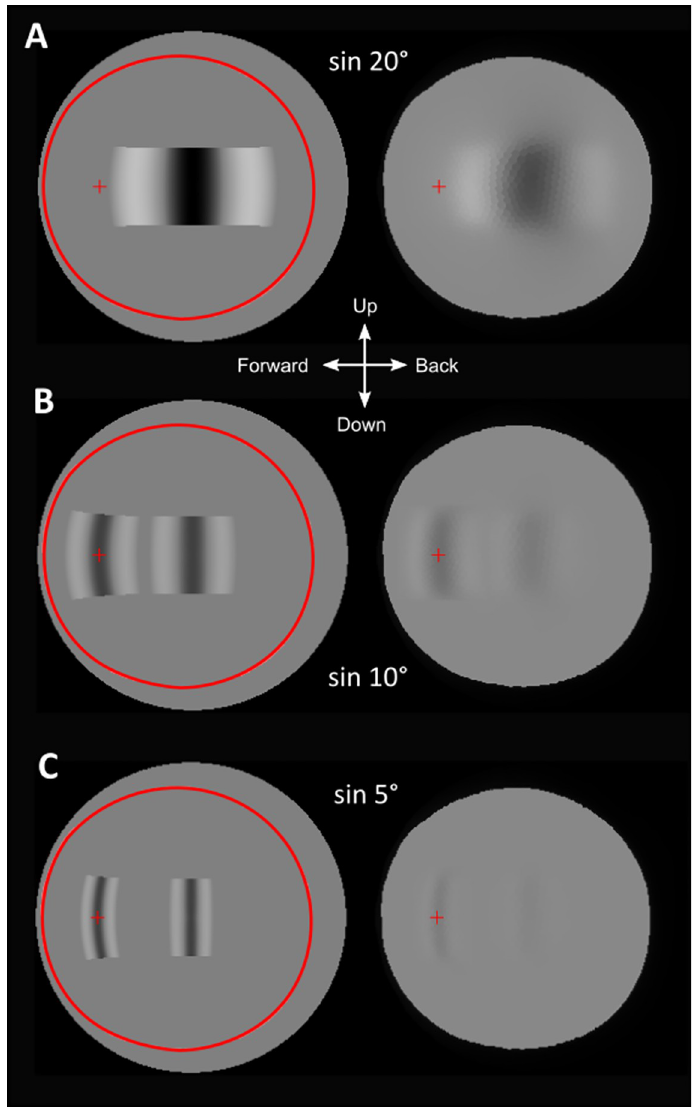
Fig 8. Behavioural test patterns. The input images (left) includes test patterns of piecewise sine functions or difference of gaussians used in behavioural experiments by Kirwan et al. [9]. The topmost figure shows a 20˚ target clearly visible even in the lowest resolving area. The centre and bottom are target patterns of 10˚ and 5˚ respectively in both the lateral part of the visual field and forward field. At 5˚ The pattern is barely visible in the forward direction (this is a pattern that did not evoke a behavioural response